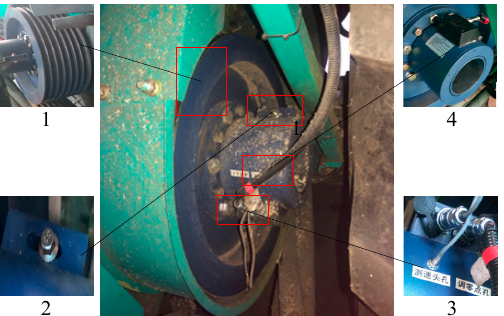
Figure 2. Physical view of shredding power sensor. 1: elastic pulley; 2: mounting base; 3: torque sensor; 4: speed sensor.